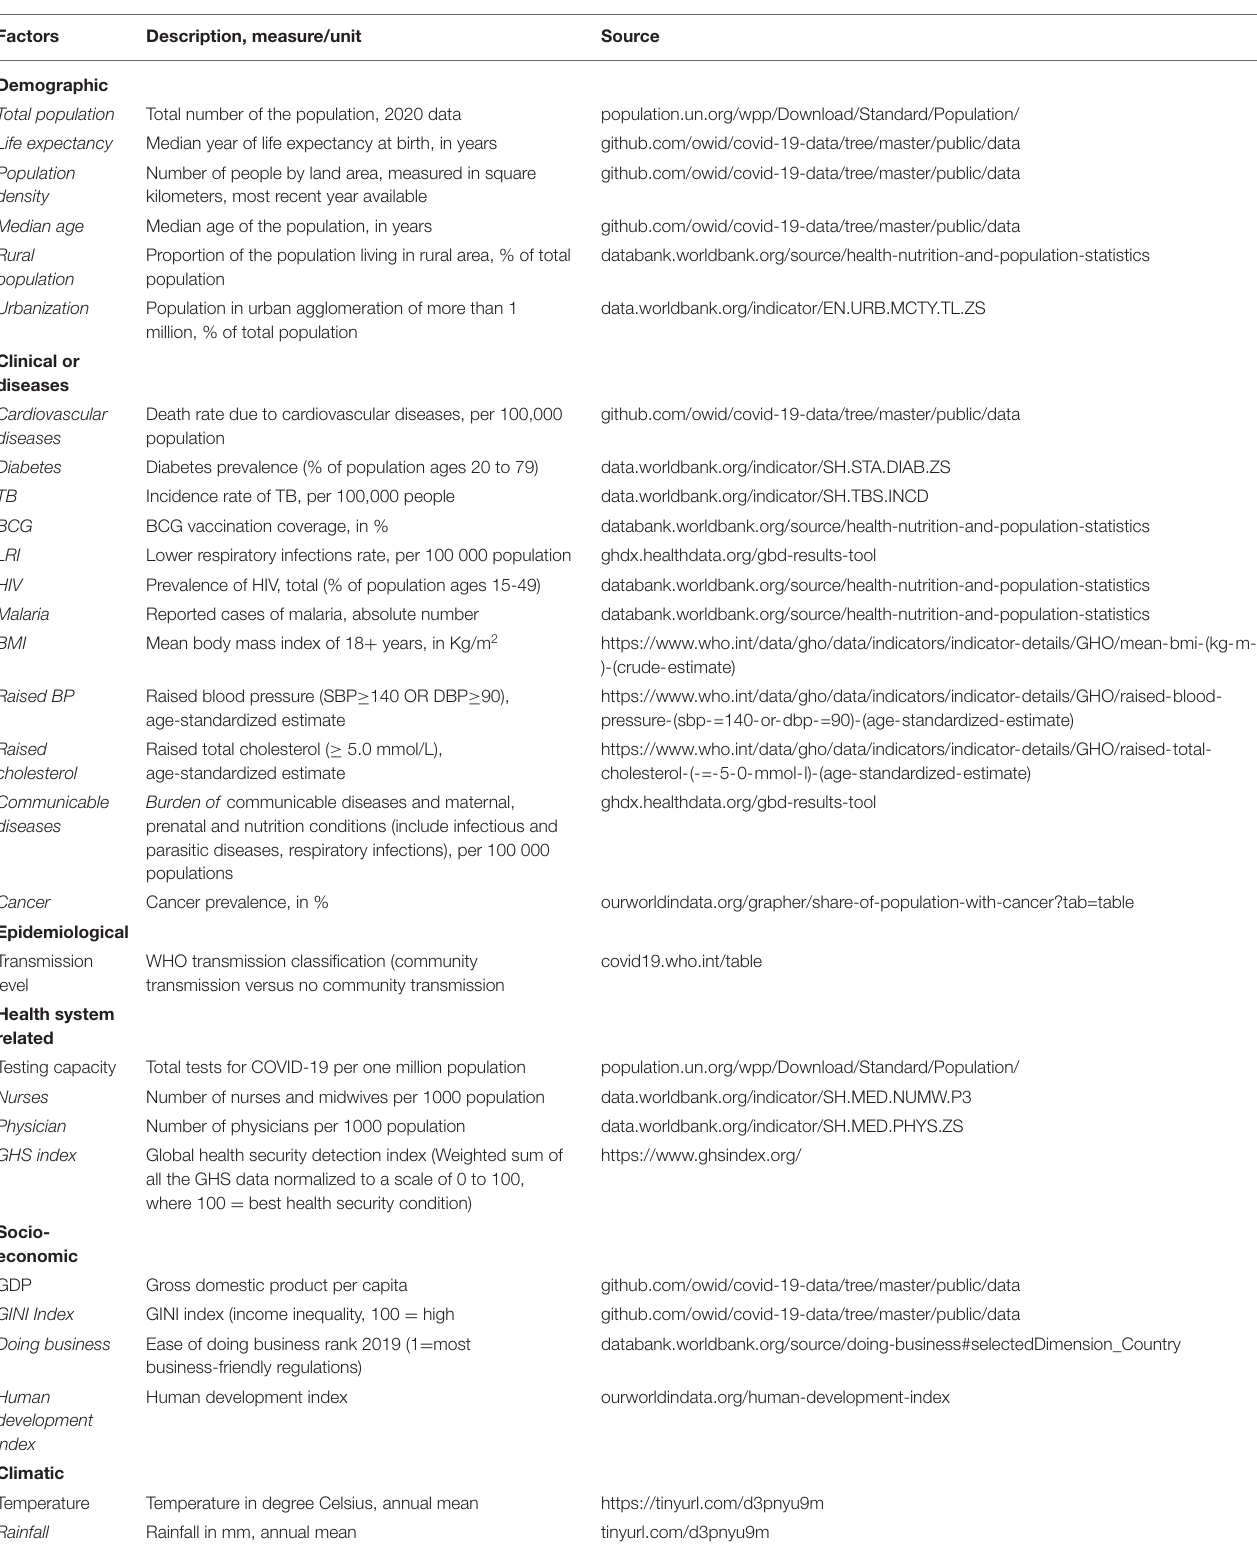
TABLE 1 | List of independent variables collected from various online sources.